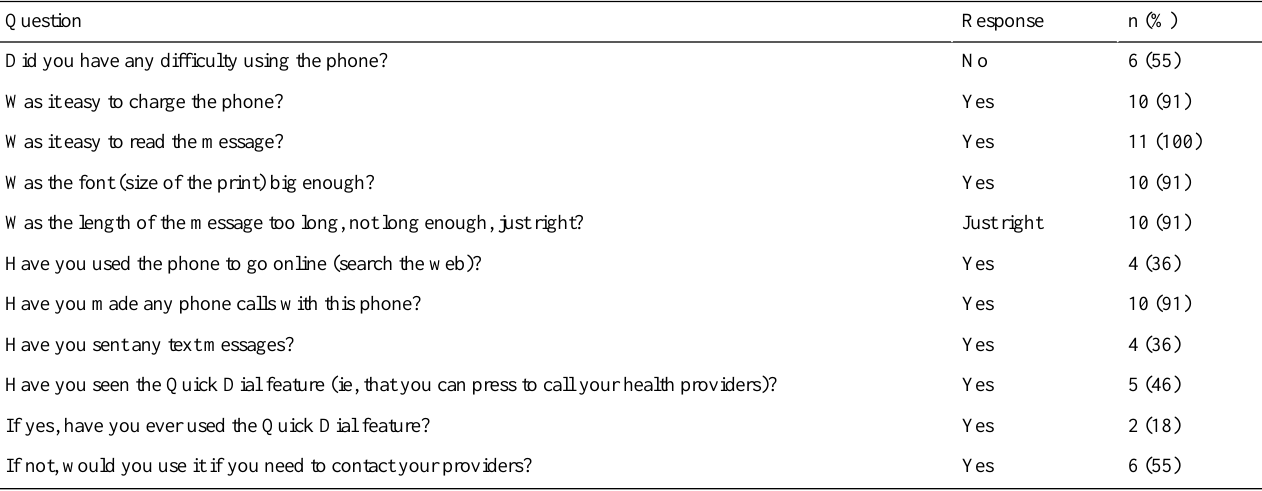
Table 2. Postintervention experience with the project and phone usage